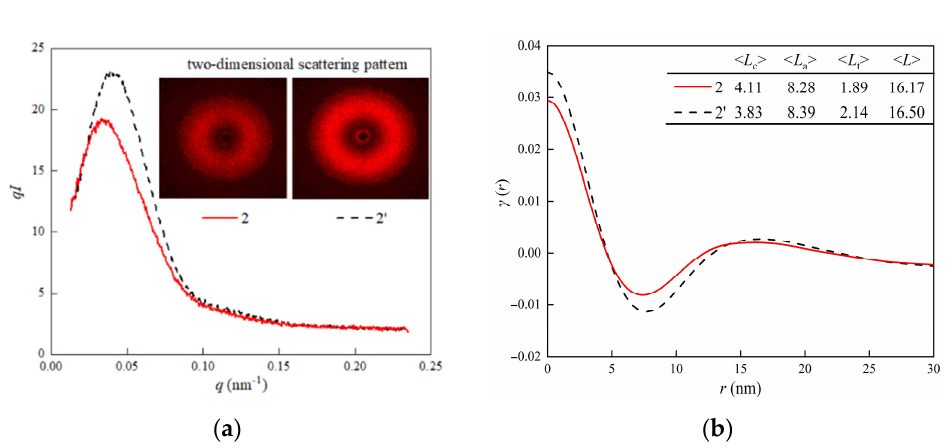
Figure 7. Small-angle scattering spectrum: ( a ) I ( q )- q curves, where the inset gives two-dimensional scattering patterns of both specimens; ( b ) one-dimensional correlation function curve, where the table gives the periodic crystal morphology parameters.